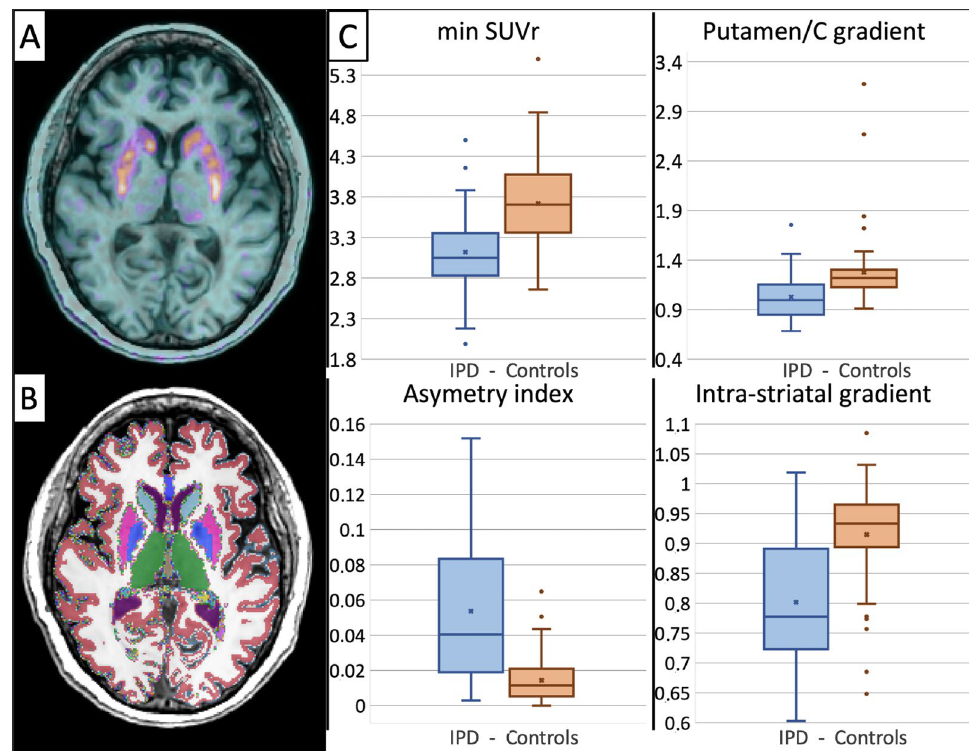
Fig. 5 Subgroups distributions of 18 F-DOPA PET semi-quantitative metrics. A fused 18 F-DOPA PET/T1weighted MRI normalized in the MNI space of a control subject. B MNI-normalized T1-weighted MRI, overlaid with corresponding Freesurfer-based automated segmentation labels ( C ). Subgroups distribution of the four 18 F-DOPA PET extracted metrics, for which a statistical between group difference was verified, values and p values are